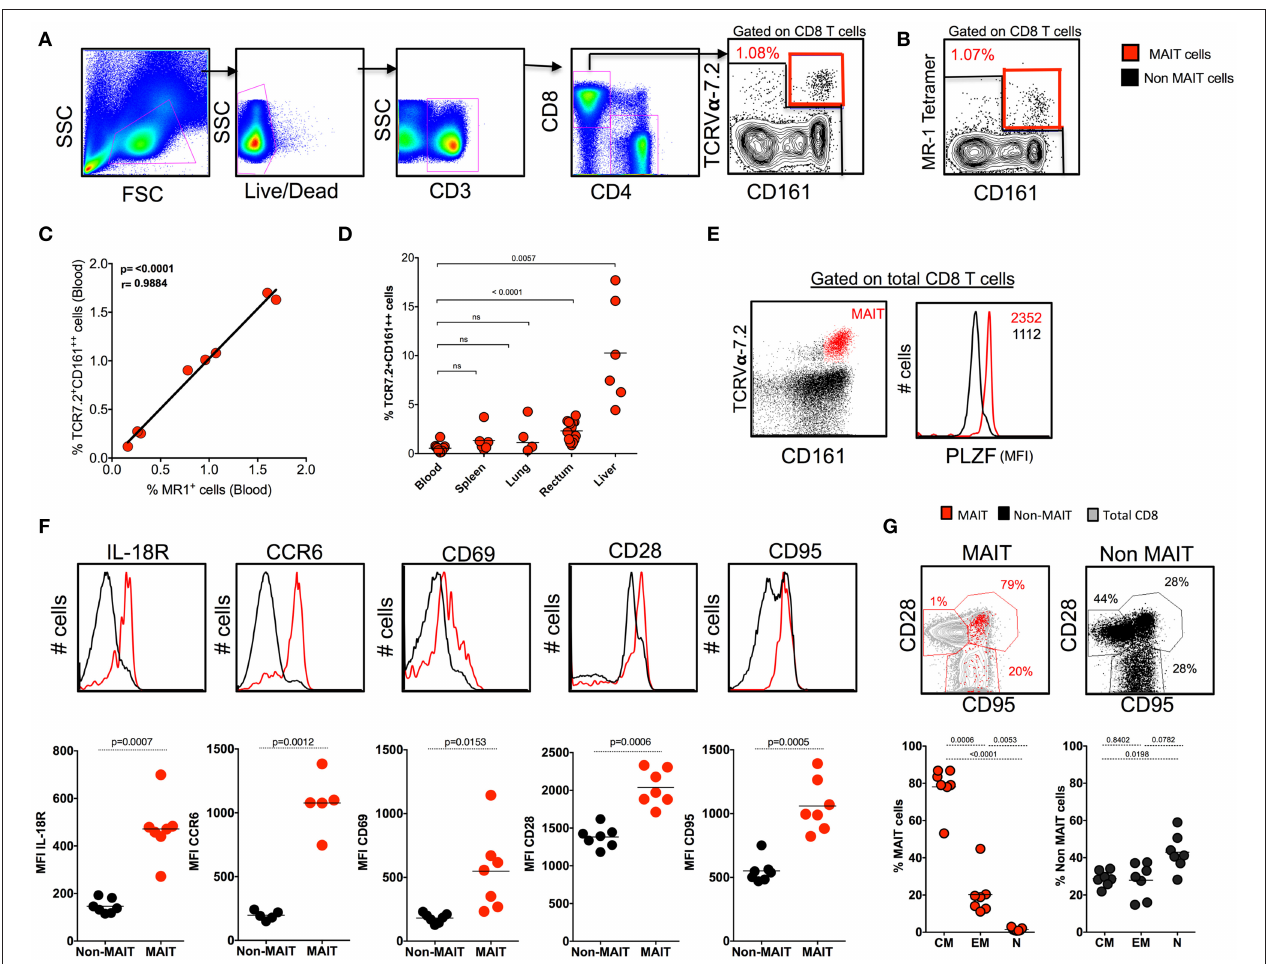
FIGURE 1 | Identification of MAIT cells using TCR7.2, CD161, and MR1 tetramer in SHIV-naïve rhesus macaques. (A) Representative FACS plot showing the gating strategy for identifying MAIT cells (CD161 ++ TCR7.2 + T cells) in healthy rhesus macaques. MAIT cells are shown in red, and non-MAIT cells are shown in black. (B) Representative flow plot shows MAIT cell (gated on CD3 + CD8 + cells) characterized by the expression of mamu MR-1 tetramer (5-A-RU) staining from the same animal displayed in (A) . (C) Graph showing the correlation between CD161 ++ TCR7.2 + T cells and MR1 + CD161 ++ T cells ( n = 8). (D) Dot plot showing the frequency of MAIT cells in various tissues form SHIV-naïve animals. (E) Representative flow plots showing the expression of MAIT cells with CD161 and TCR7.2 and its relative expression of transcription factor PLZF. (F) Representative flow plots showing the expression of different phenotypic markers IL-18R, CD69, CCR6, CD28, and CD95 by MAIT and non-MAIT cells, mean fluorescence intensity of each marker is displayed. (G) Representative FACS plots showing the expression of CD28 and CD95 on MAIT and non-MAIT cells of blood and also the frequencies of central memory (CD28 + CD95 + ), effector memory (CD95 + CD28 − ), and naïve (CD28 − CD95 − ) between MAIT and non-MAIT cells ( n =